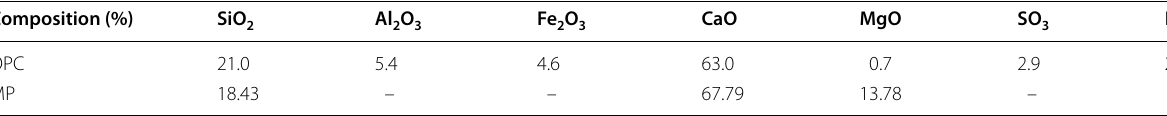
Table 1 Composition of OPC and marble